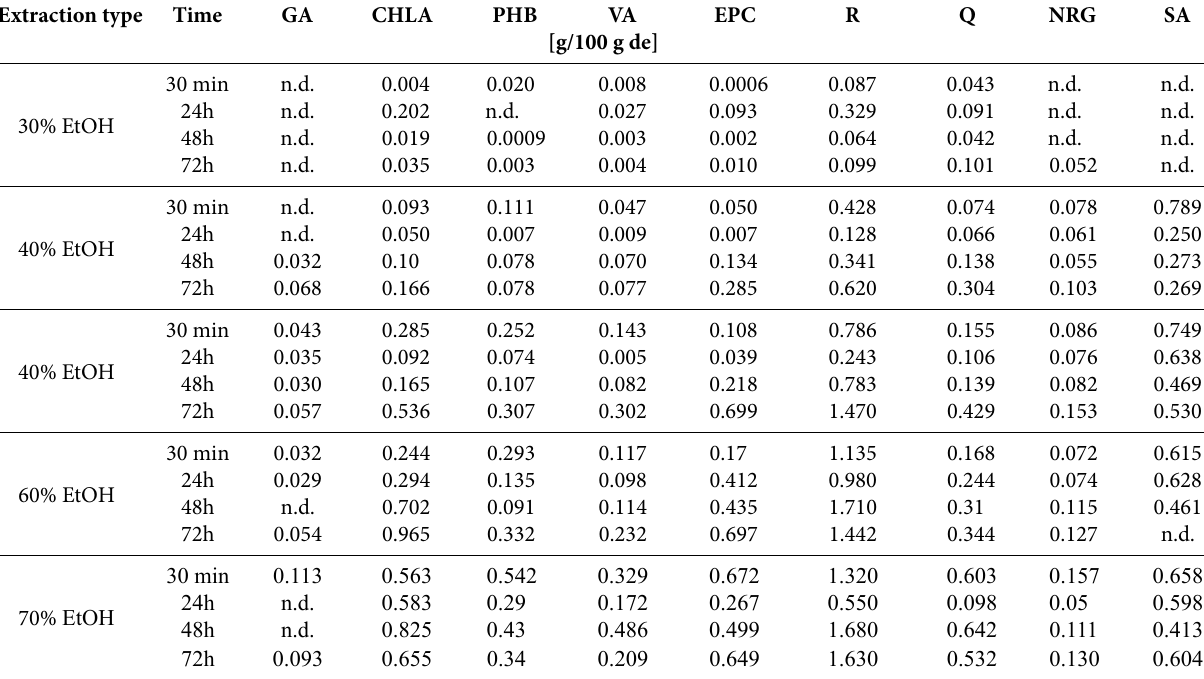
Table 6. Chemical composition of Salix caprea bark extracts Extraction